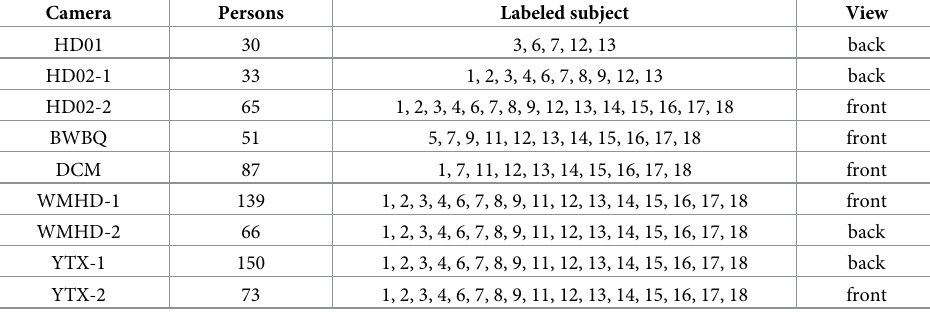
Table 1. A brief description of different gait sequences in the PKU dataset. Camera